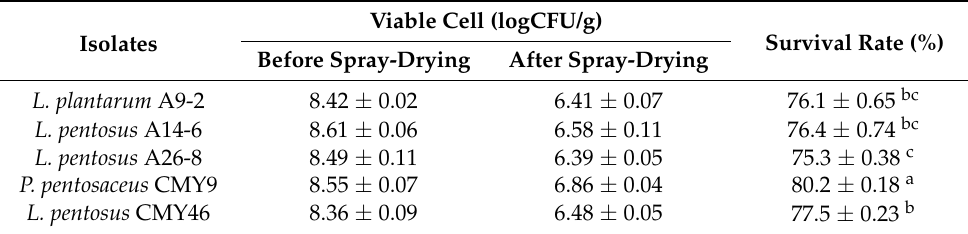
Table 4. Survival of five selected LAB isolates after spray-drying with maltodextrin as the